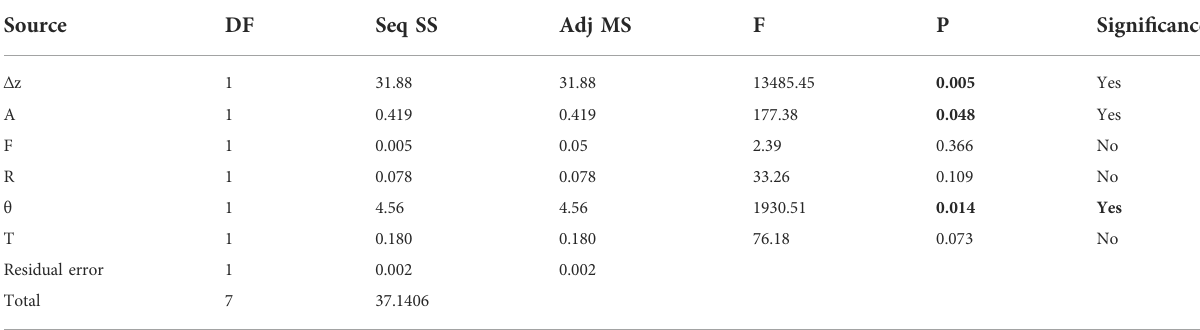
TABLE 2 ANOVA results for R for AA3003-O.